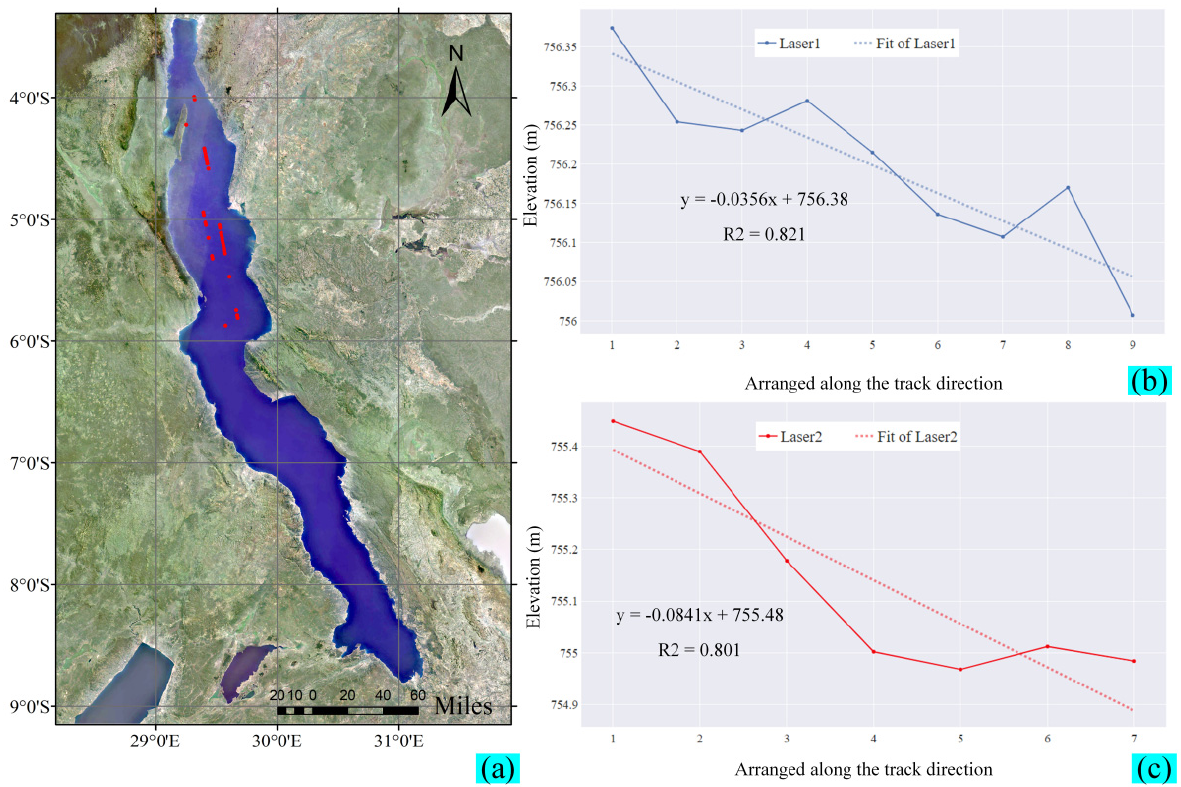
Figure 10. ( a ) Distribution of laser spots across Lake Tanganyika. ( b ) Height profile of beam #1 along the track and ( c ) height profile of beam #2 along the track.